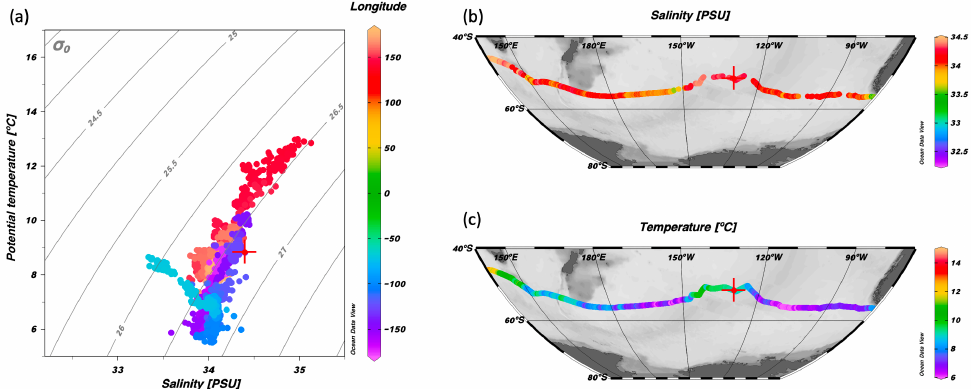
Figure 7. ( a ) Temperature − Salinity diagram using the filtered in-situ data in the Pacific Ocean (colors indicate the longitude ( ◦ ) and contours represent the ispycnals σ θ ). ( b ) Salinity (psu) and ( c ) temperature ( ◦ C) recorded in the Pacific